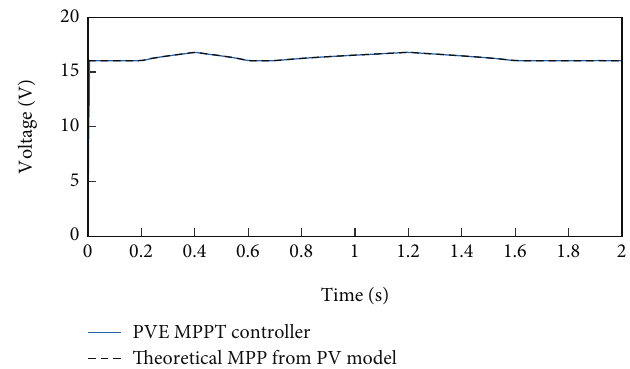
Figure 27: Voltage of the PVE system with MPPT control under the EN 50530 test.